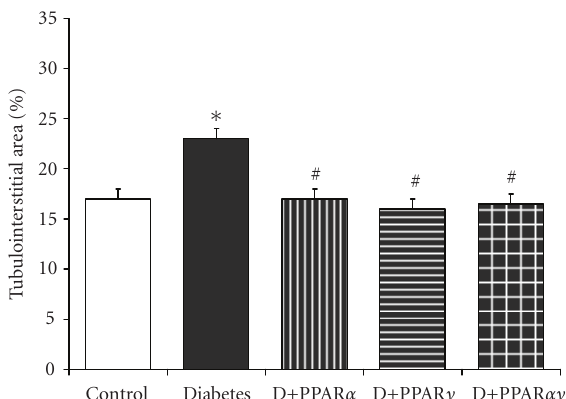
Figure 4: Gene expression of the angiotensin II subtype 1 receptor as assessed by real-time RT-PCR in aorta from apoE knockout mice treated with the PPAR γ agonist, rosiglitazone or the PPAR α agonist, gemfibrozil for 20 weeks. P < .05 versus diabetic